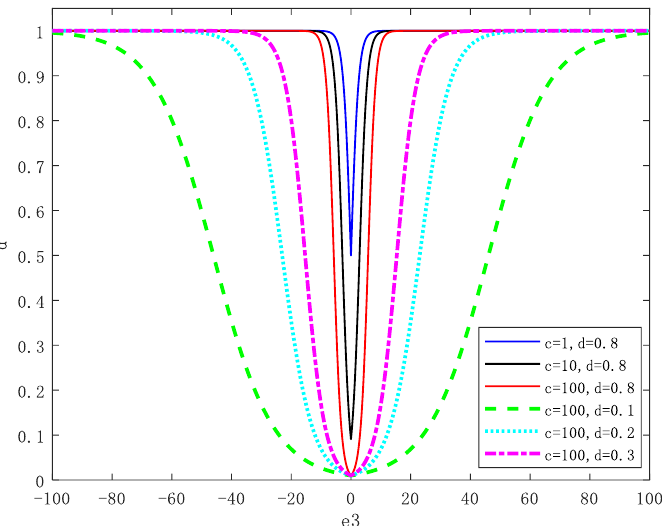
Figure 8. Diagram of influence of control parameters on adaptive function. Parameter c will affect the minimum value of α , and parameter d will affect the parameter adjustment speed of the adaptive function. The parameter adaptation method shown in Equation (39) can not only react and suppress external interference quickly, but also reduce the chattering of the system as much as